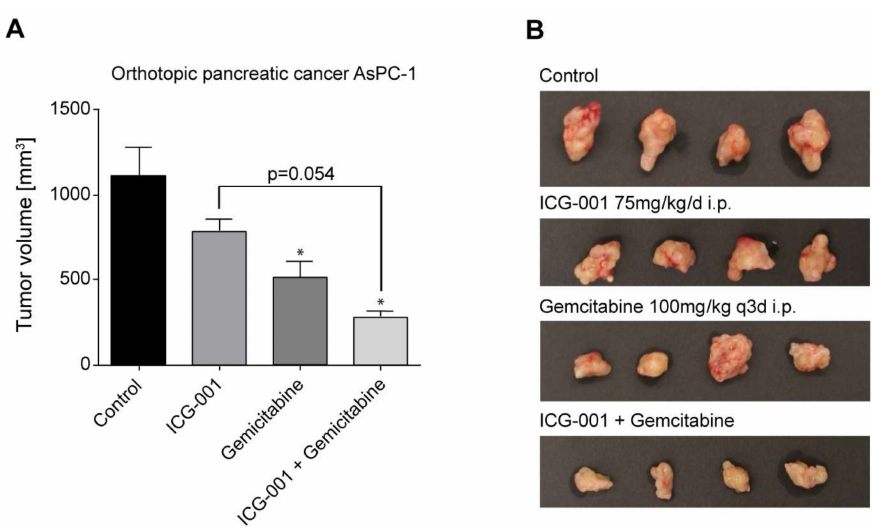
Figure 4. Combination ICG-001 and gemcitabine treatment suppresses pancreatic tumor growth in an orthotopic mouse model of PDAC. 1 × 10 5 AsPC-1 cells were injected into the pancreas of nu/nu mice. After 5 days, treatment was initiated with 4 groups, i.e., saline control, ICG-001 75 mg/kg/day i.p., gemcitabine 100 mg/kg/day twice a week i.p., or the combination. Treatment was continued for 6 weeks at which point mice were sacrificed and tumors examined. ( A ) Tumor volume